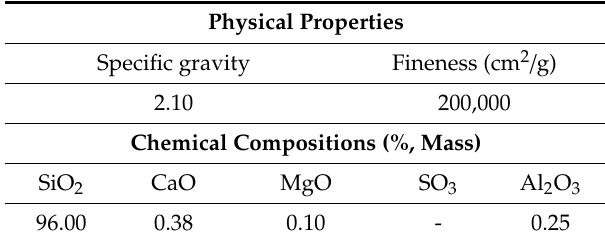
Table 2. Material properties of silica fume [12,20].